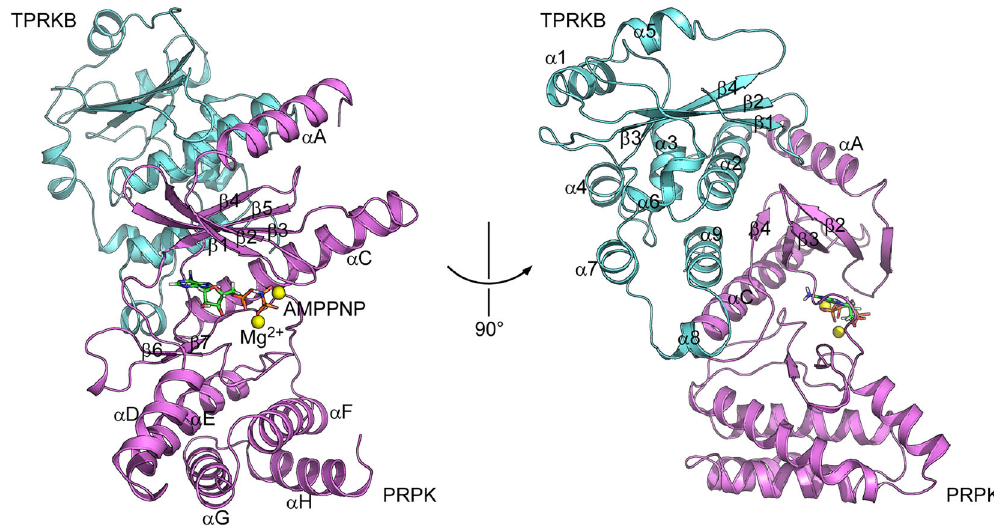
Fig. 1 Overall structure of the human PRPK – TPRKB – AMPPNP complex. PRPK adopts a kinase fold with a briefed C-lobe. TPRKB uses the β 1- β 2 loop, α 2, α 8, and α 9 to interact with the PRPK N-lobe. PRPK is colored in violet and TPRKB in aquamarine. AMPPNP is shown as stick and Mg 2 + as yellow